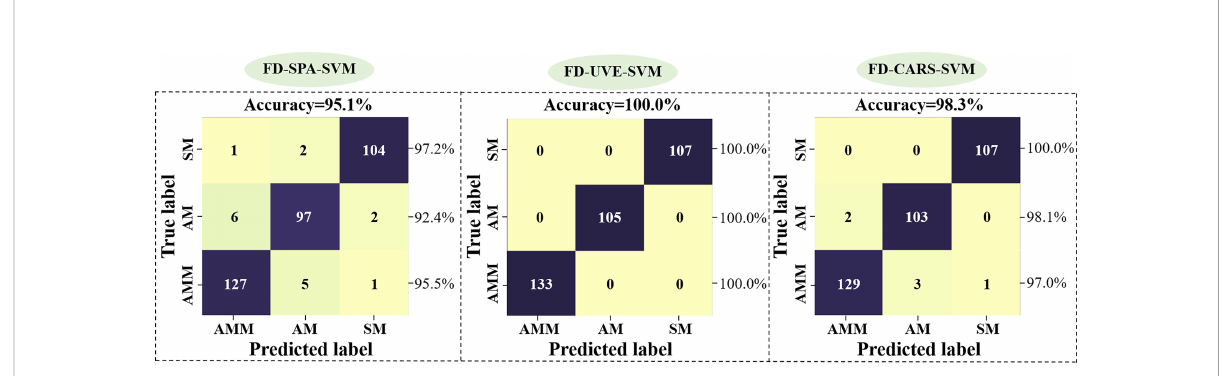
FIGURE 7 Validation of SVM model accuracy based on EW data selected by SPA (left), UVE (middle) or CARS (right)